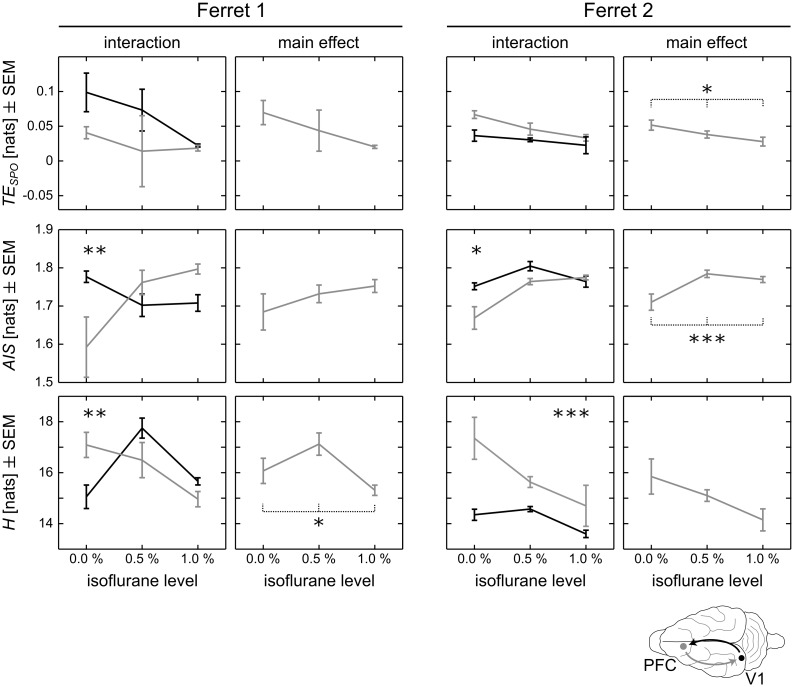
pANOVA results for Bayesian estimates of transfer entropy (TESPO), active information storage (AIS), and entropy (H).Left columns show interactions isoflurane level x direction and isoflurane level x recording site for both animals; right columns show main effects isoflurane level. Grey lines in interaction plots indicate TESPO from prefrontal cortex (PFC) to primary visual areas (V1), or H and AIS in PFC; black lines indicate TESPO from V1 to PFC, or H and AIS in V1. Error bars indicate the standard error of the mean (SEM); stars indicate significant interactions or main effects (*p < 0.05; **p < 0.01; ***p < 0.001).